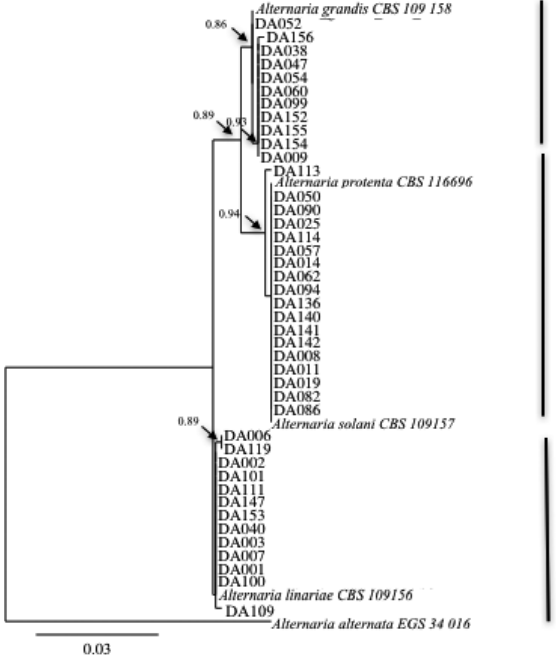
Figure 3. Phylogenetic tree reconstructed by the maximum likeli- hood method from the alignment of calmodulin sequences of 42 isolates belonging to the Alternaria section Porri . Bootstrap support values greater than 80 % are indicated by arrows. The calmodu- lin sequences of the following strains were included as references: A. linariae CBS 109156 (GenBank number JQ646257), A. protenta CBS 116696 (GenBank number JQ646236), A. solani CBS 109157